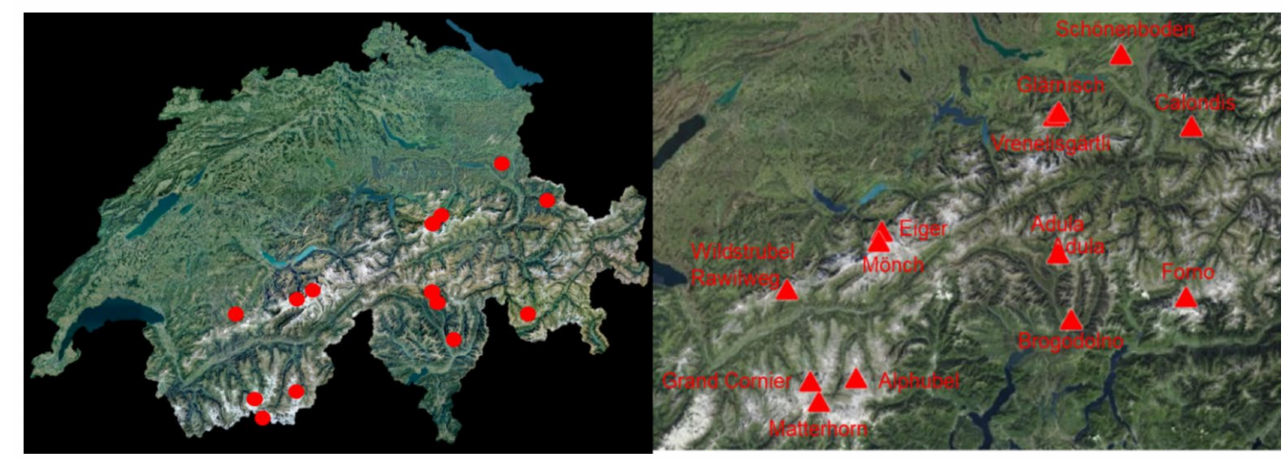
Figure 2. Geographic locations of lightning strikes in the Swiss Alps (map from Swisstopo [31]). Interestingly, cases are along the main massive of the alps.